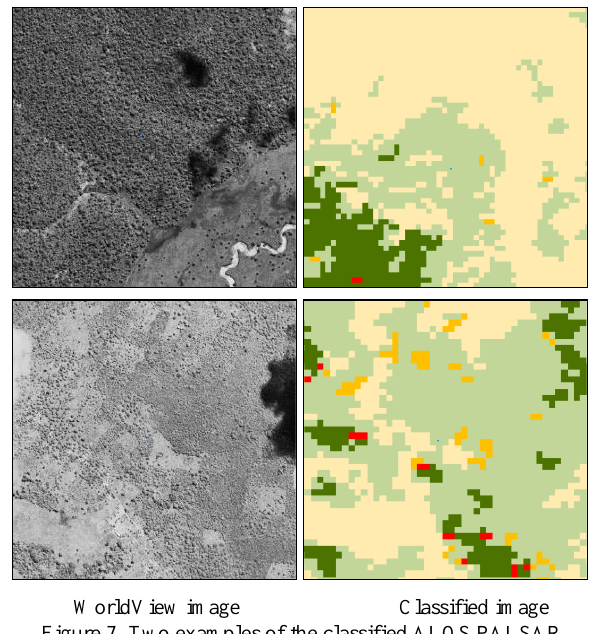
Figure 7. Two examples of the classified ALOS PALSAR image compared with the WorldView image. Dark green: forest. Light green: woodland. Beige: non-forest. Red: forest loss. Orange: woodland loss.